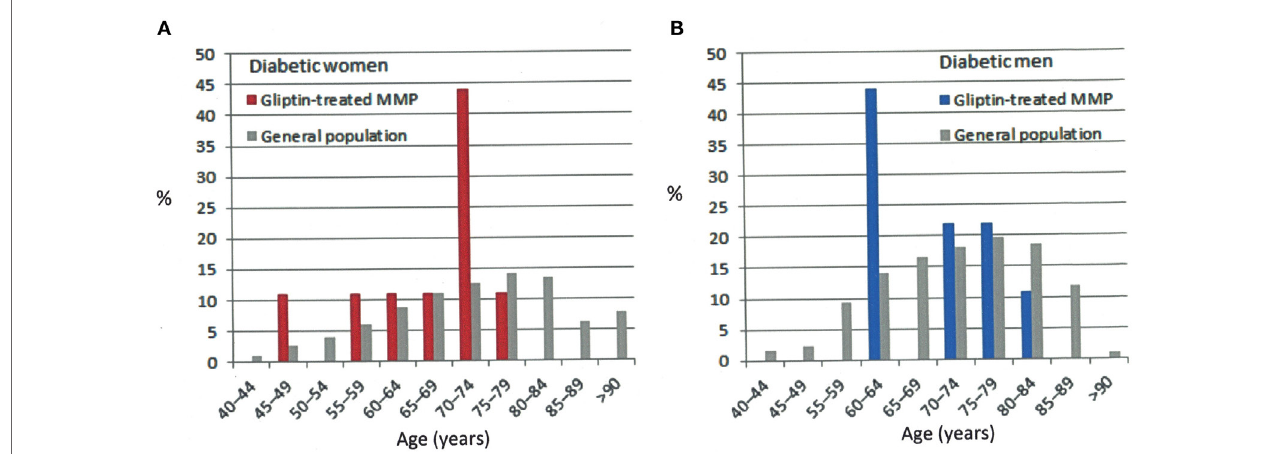
FigUre 2 | Percentage of patients by age group in the general diabetic population and our suggestive-or-compatible gliptin-induced mucous membrane pemphigoid group: (a) in women, (b) in men, diabetic patients